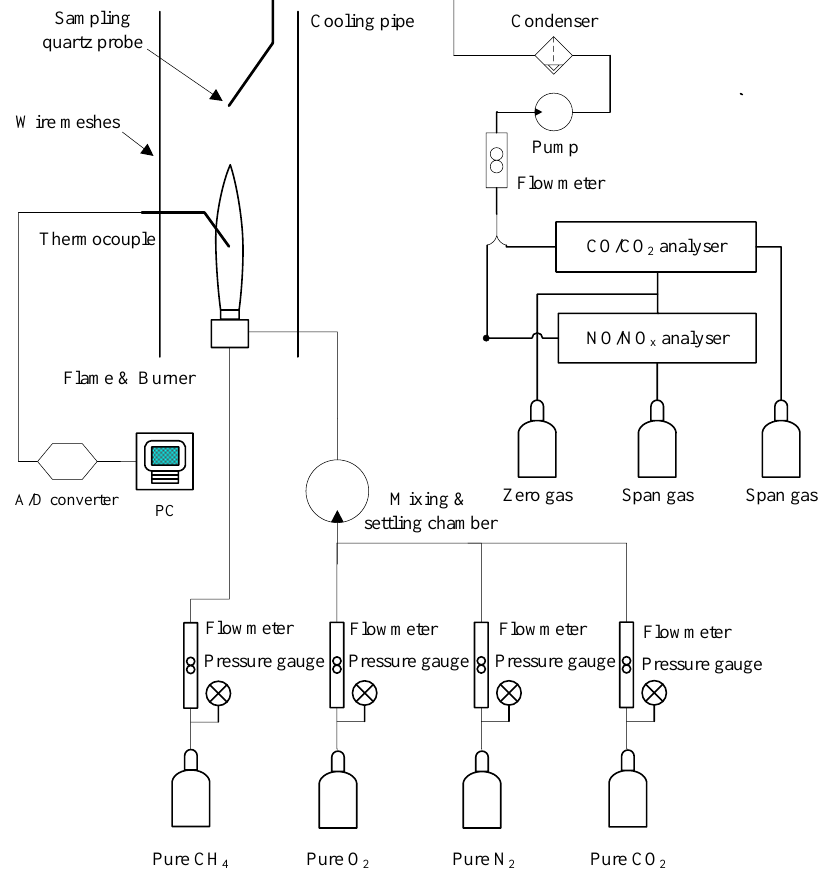
Figure 1. Sketch of the experimental apparatus.